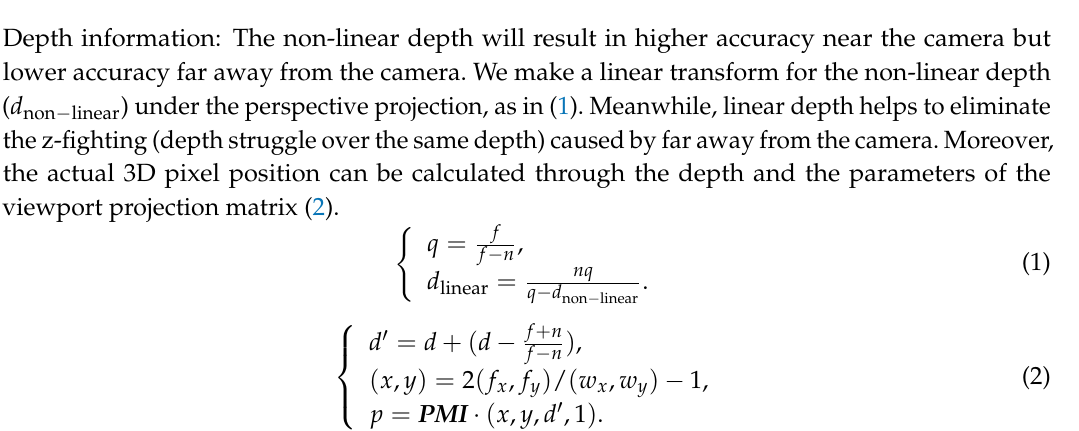
Figure 2. The sample mask of the current